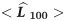
The Standard Condition (n = 30 simulations per condition).a. Examples of displacement profiles applied to the agent-molecules. b. Examples of the molecular distributions obtained after 5 min simulations with the target values set at (i) 7, (ii) 25, (iii) 45, (iv) 55, (v) 67 encircled molecules. c. Corresponding <L^100> values extracted from all molecules over time (depicted blue) and their associated fixed targets (depicted red). d. Convergence time and e. Error as a function of the number of molecules for each L100 target (depicted in blue are the values obtained for each target, in dashed grey the point after which the system takes longer than 5 min to converge and in solid grey, the “cut-off” point).